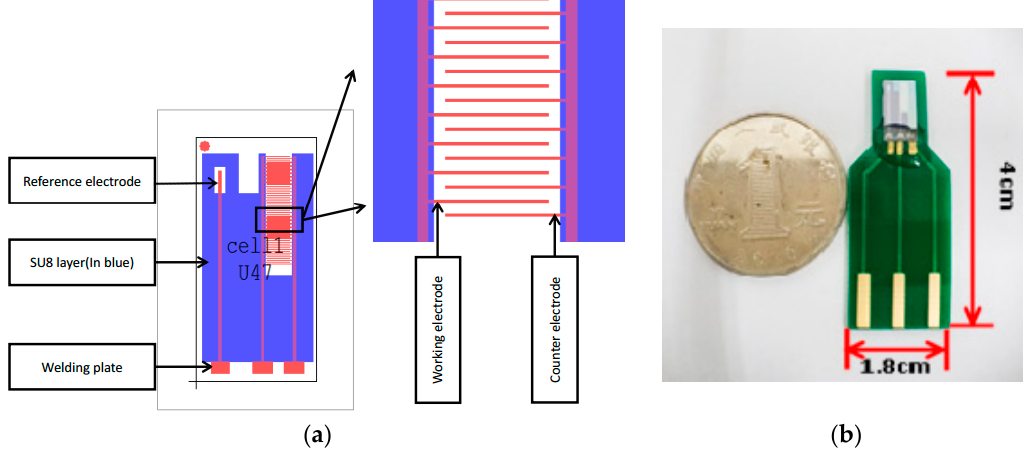
Figure 1. ( a ) The structure diagram and ( b ) the picture of the ultramicro interdigital electrode array chip.